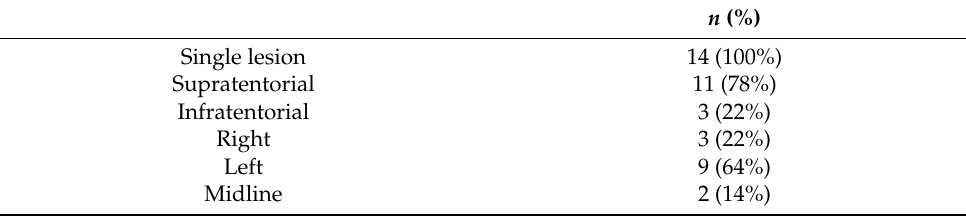
Table 2. Localization of p-HGG.